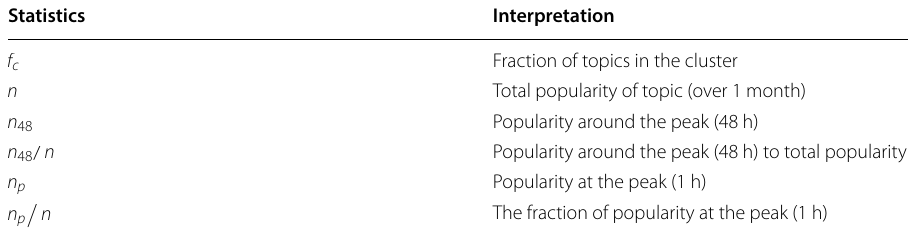
Table 4 Interpretation of statistics